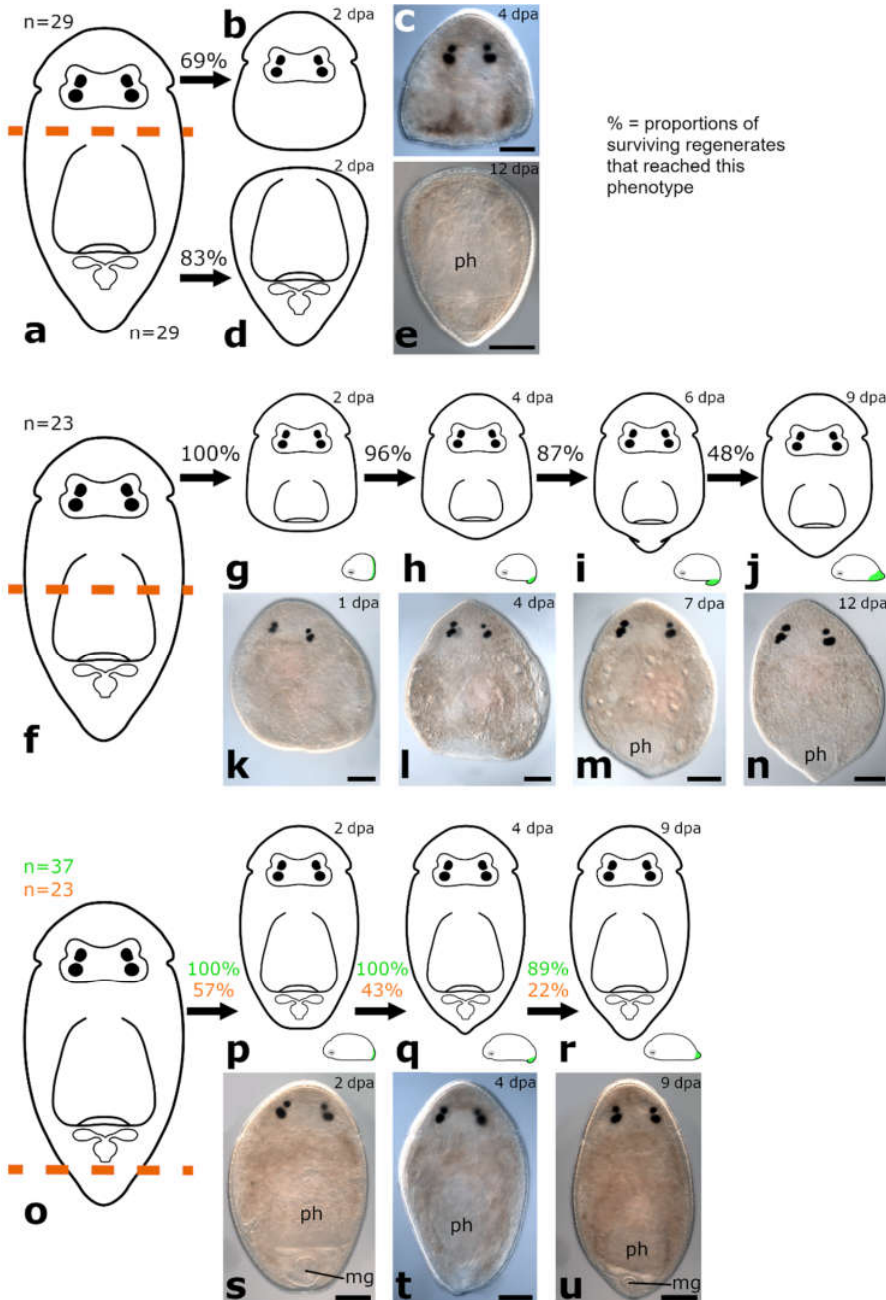
Figure 4. Regeneration in Cylindrostoma monotrochum . Amputation between brain and pharynx ( a ): complete wound healing in posterior regenerates ( b , c ) and anterior regenerates ( d , e ); no missing body parts were regenerated. Amputation through the middle of the pharynx ( f ): posterior regenerates fully healed the wound ( g , k ). Few days later, an unpigmented, blastema-like structure, which was bend towards the ventral side ( h , l ), and continuously grew and tapered ( i , m ) was observed. The newly built tail tip was no longer bent to the ventral side ( j , n ). Amputation posterior to the pharynx ( o ): complete wound healing in posterior regenerates in the field (green) and under laboratory conditions (orange) ( p , s ). A blastema-like structure, which was bend towards the ventral side was build ( q , t ), and led to a complete regeneration of the missing tail tip ( r , u ). Same individual shown in ( k – n ). Abbreviations: mg, male genital organ; ph, pharynx. Scale bar is 100 µm.